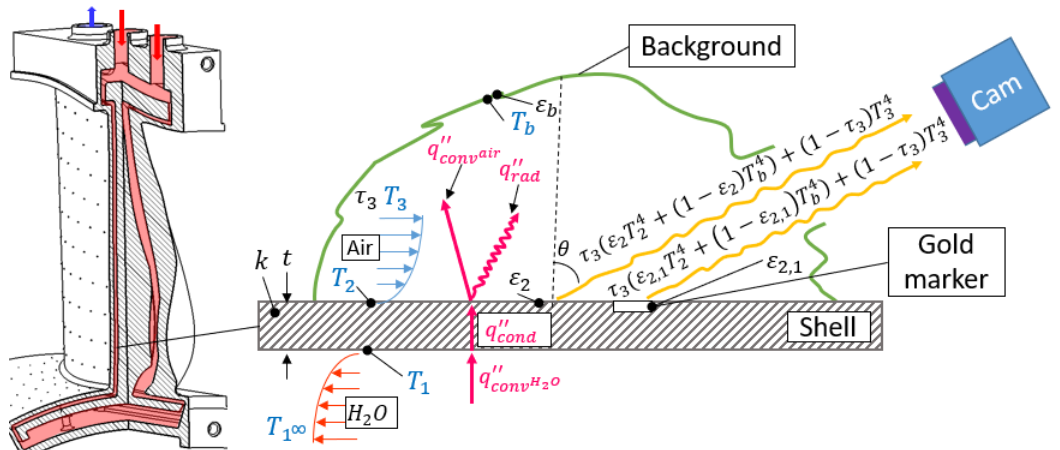
Figure 3. Isometric view of the instrumented OGV to the left. Schematic of problem formulation can be seen to the right and further description can be found in the